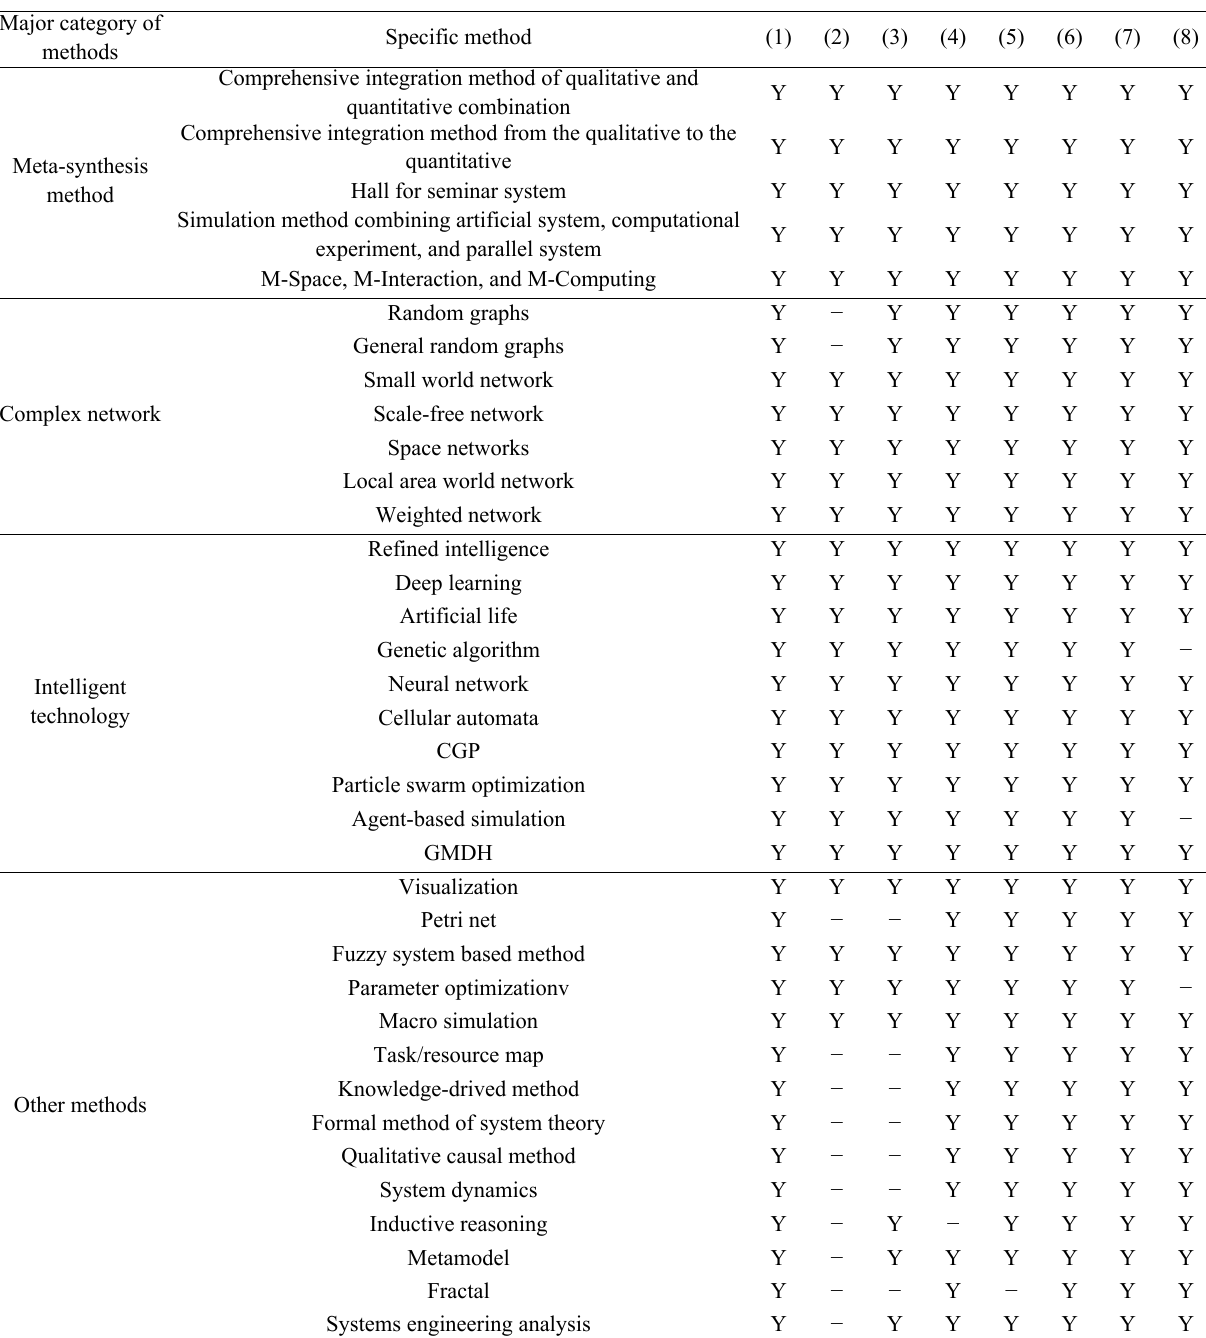
Table 1 Eight characteristics reflected by complex system simulation